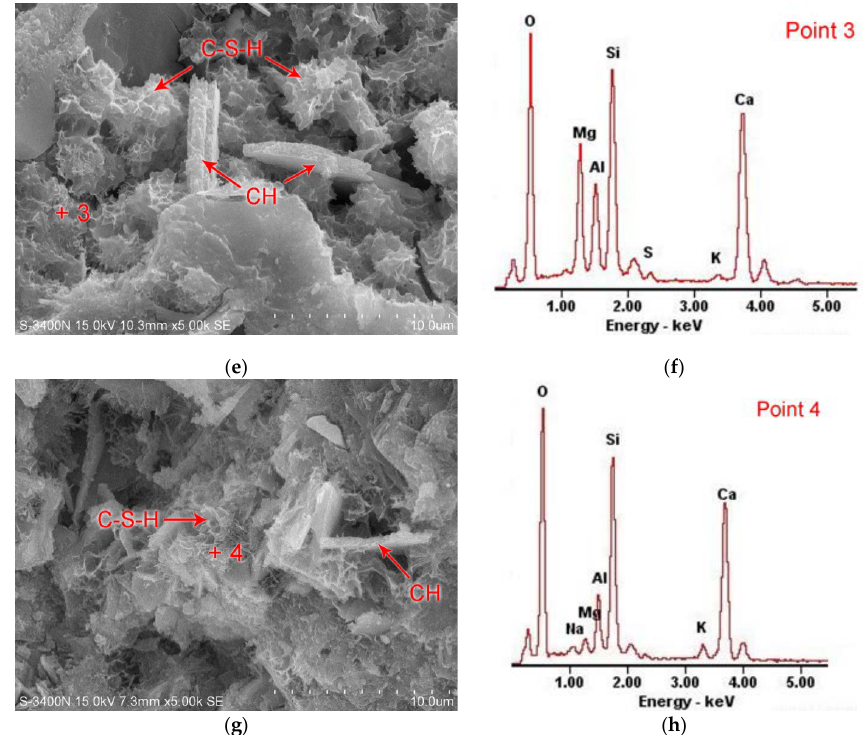
Figure 6. SEM micrographs of paste specimen of different SSA of GGBS and EDS in micro-area. ( a ) SEM micrograph of reference mortar at 28 days. ( b ) EDS of point 1 in micro-area of paste samples. ( c ) SEM micrograph of KB Test mortar at 28 days. ( d ) EDS of point 2 in micro-area of paste samples. ( e ) SEM micrograph of KD Test mortar at 28 days. ( f ) EDS of point 3 in micro-area of paste samples. ( g ) SEM micrograph of KF Test mortar at 28 days. ( h ) EDS of point 4 in micro-area of paste